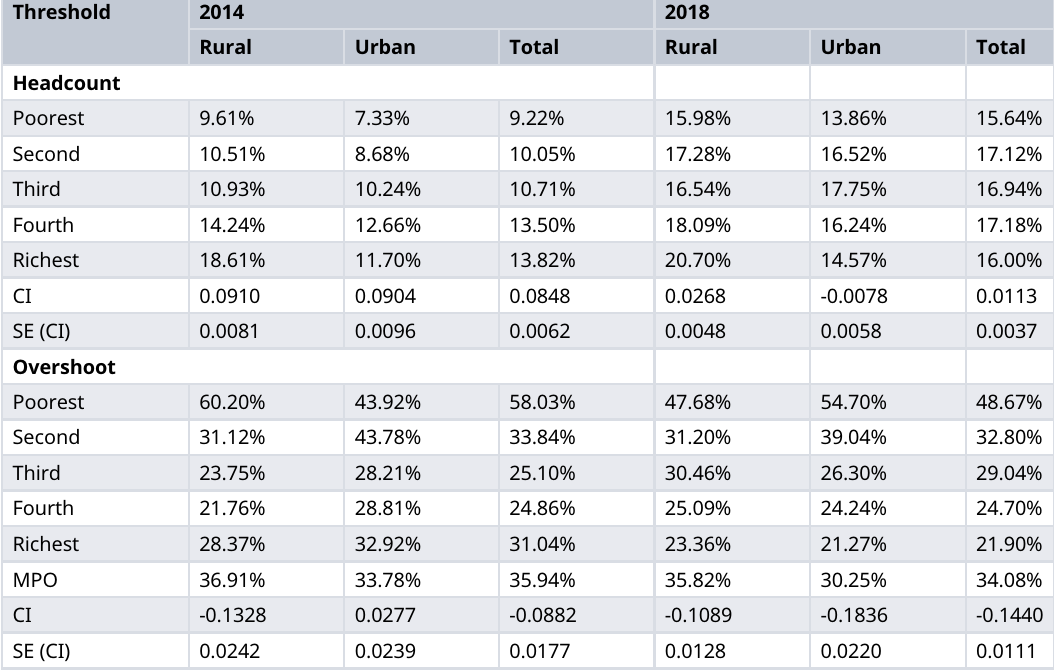
Table 4. Headcount and overshoot of CHE by socioeconomic status and